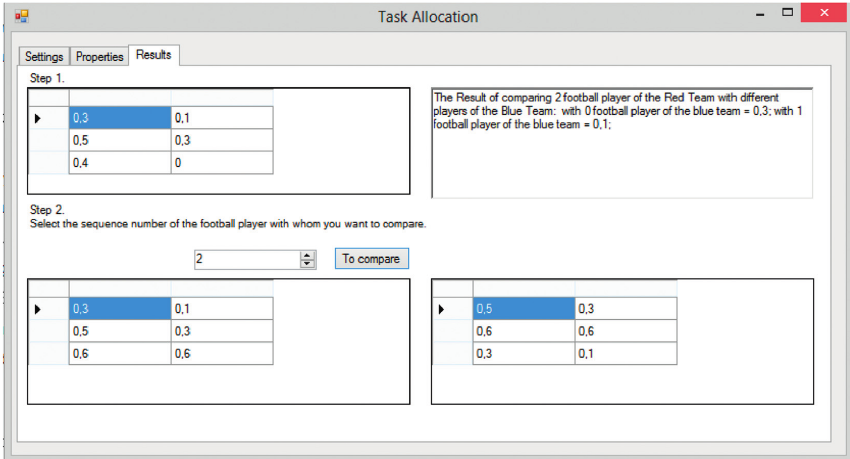
Figure 7: Result of the solution for the second MO of the red group.